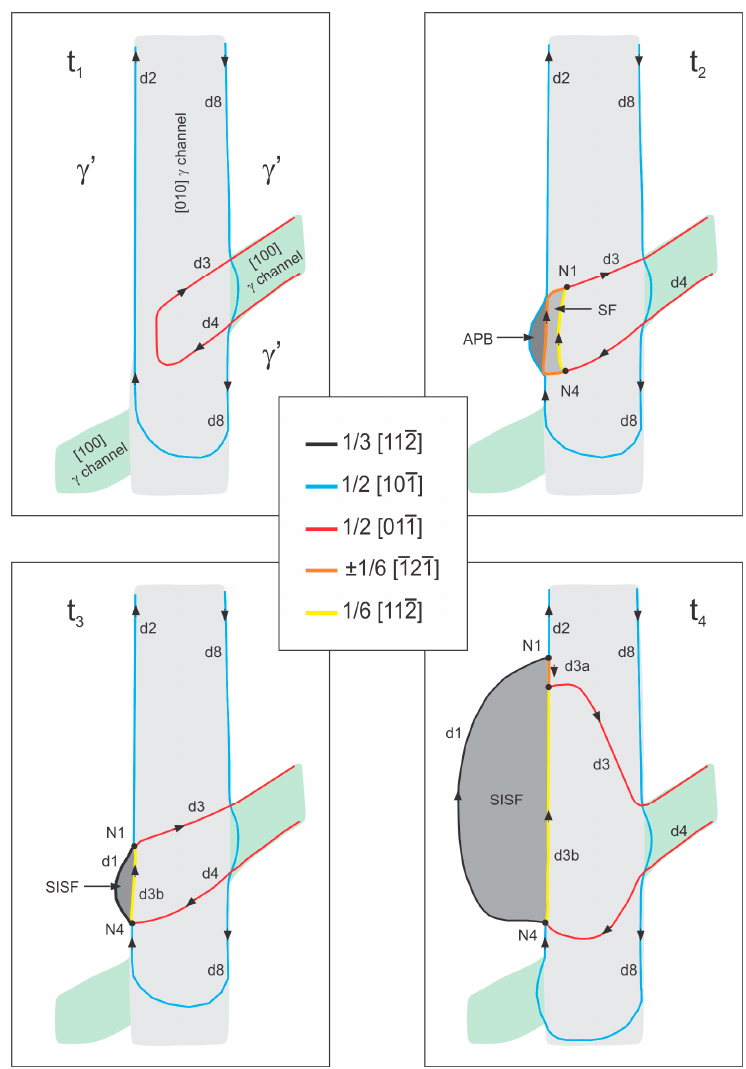
Figure 9. Simplified schematic drawings illustrating how the dislocation substructure shown in the STEM micrograph of Figure 7 has evolved. Creep exposure time increases from t1 (starting configuration) to t4 (final configuration). For details see text.